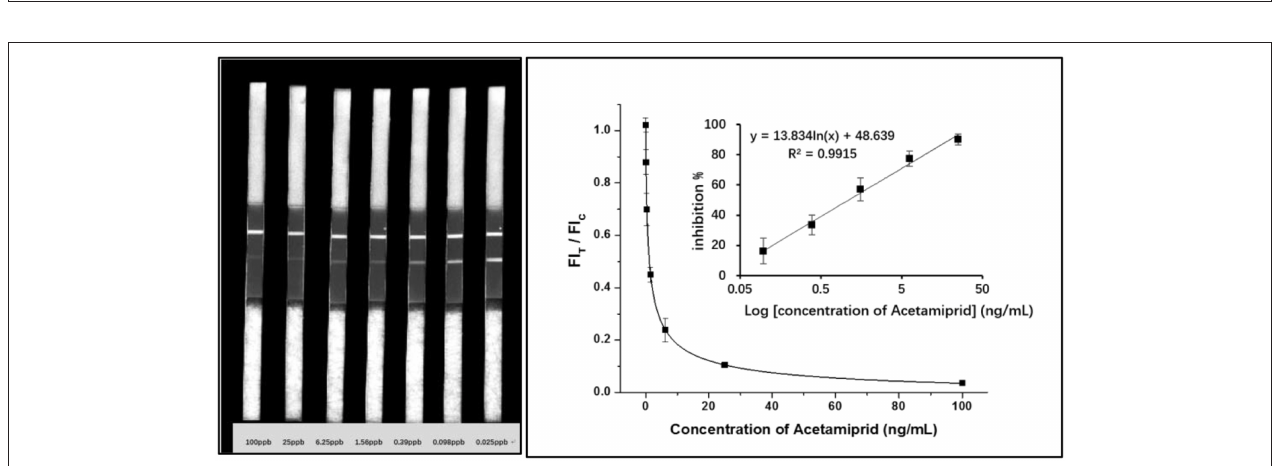
FIGURE 3 | Calibration curves obtained from gradient acetamiprid-spiked standards and relevant results of QDs-ICS.